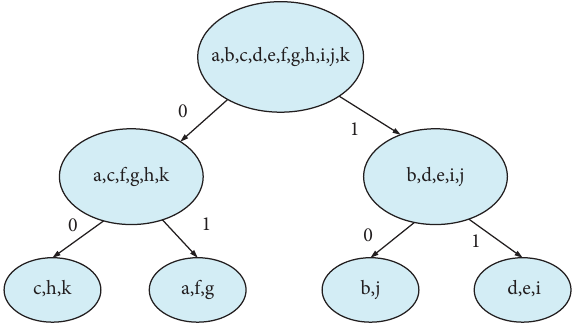
Figure 4: 2-level 2-mean clustering